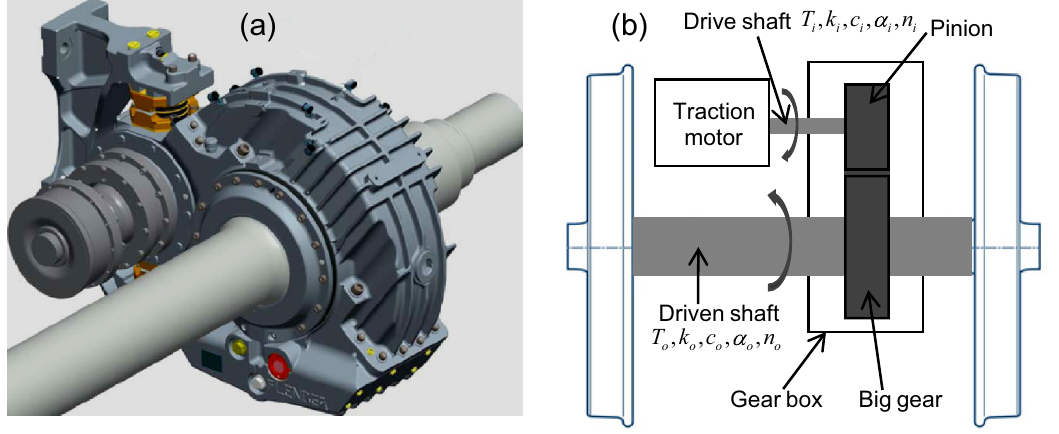
Figure 2. Gearbox model (a) and its sketch illustration of torsional vibration model (b) for a typical rail